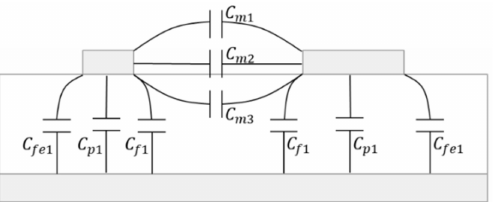
Figure 5. Cross-sectional view of coupled asymmetrical micro-strip lines and capacitance parameters. The capacitance parameters are configured by the design parameters of the coupled asymmetrical micro-strip